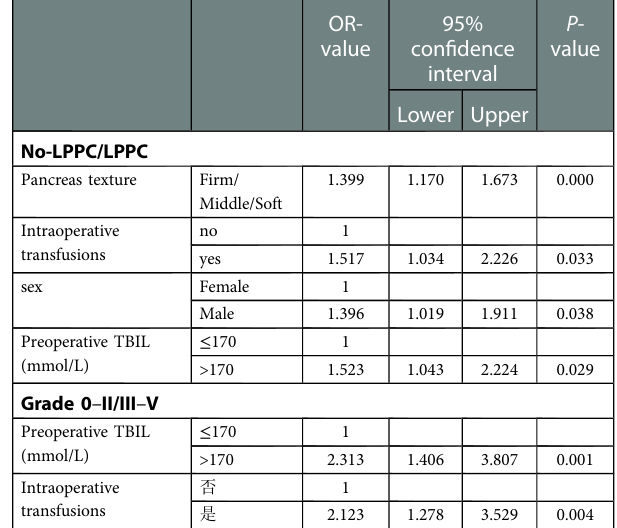
TABLE 4 Multivariate analysis of postoperative complications and severe complications.